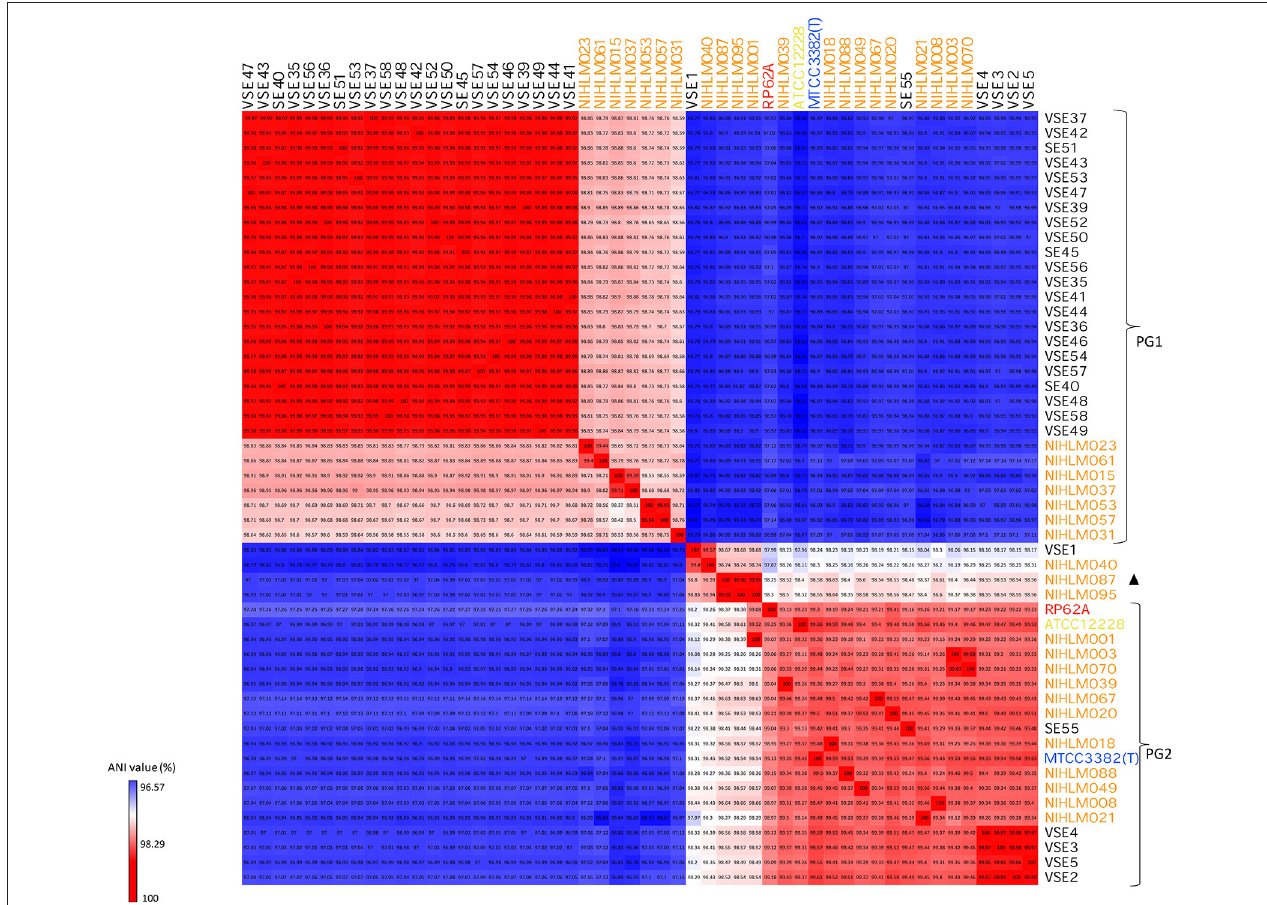
FIGURE 2 | ANI heatmap of SEI and SEA isolates. PG1 and PG2 demonstrates two kind of lineages, phylogenetic group 1 and phylogenetic group 2; Blank triangle represents transitional phase. Orange color text isolates are SEA isolates. Type strain, MTCC 3382 (T) [In blue], pathogenic strain RP62A [In red] and commensal strain, ATCC12228 [In